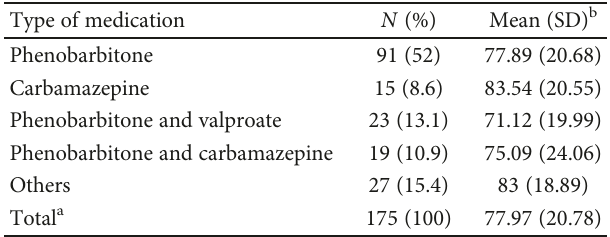
Table 6: Mean total QOL score and antiepileptic medications use by the research participants in ACSH and Mekelle hospital.